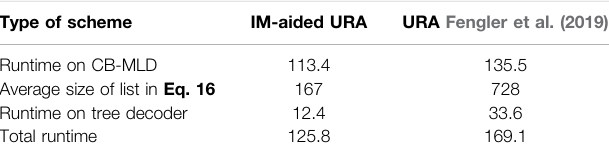
TABLE 3 | Runtime of receiver of IM-aided URA and URA (Fengler et al., 2019), L (cid:1) 100 , M (cid:1) 200 , K a (cid:1) 300 (unit: second).